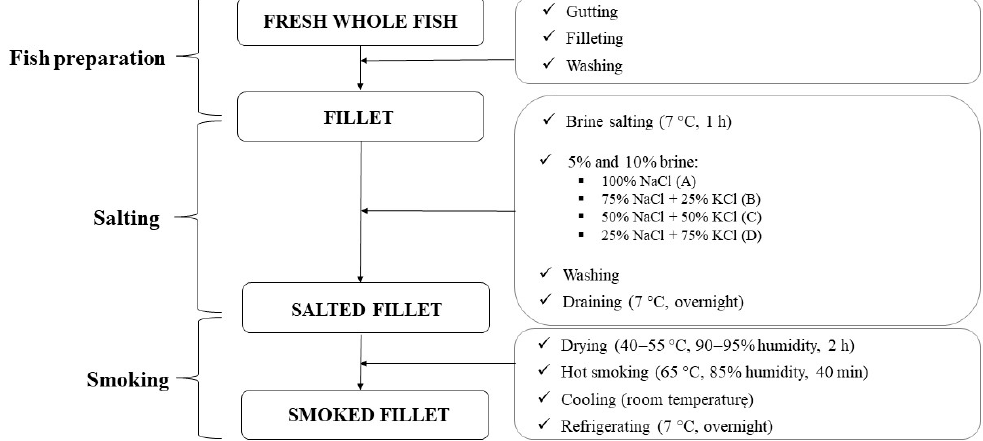
Figure 1. Scheme of the development of the smoked mackerel formulations. Thawed fillets were immersed in brines of different concentrations and combinations of NaCl and KCl. The conditions (brine strength and time) were chosen in preliminary experiments based on [16]. In total, eight formulations were prepared: half of the samples used a 5% brine and the second half used a 10% brine (n = 6 fillets (3 × 2 fillets from the